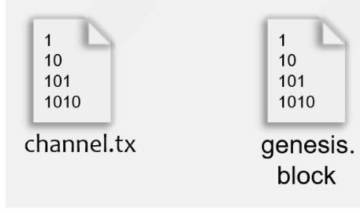
Figure 12. Member certificate.